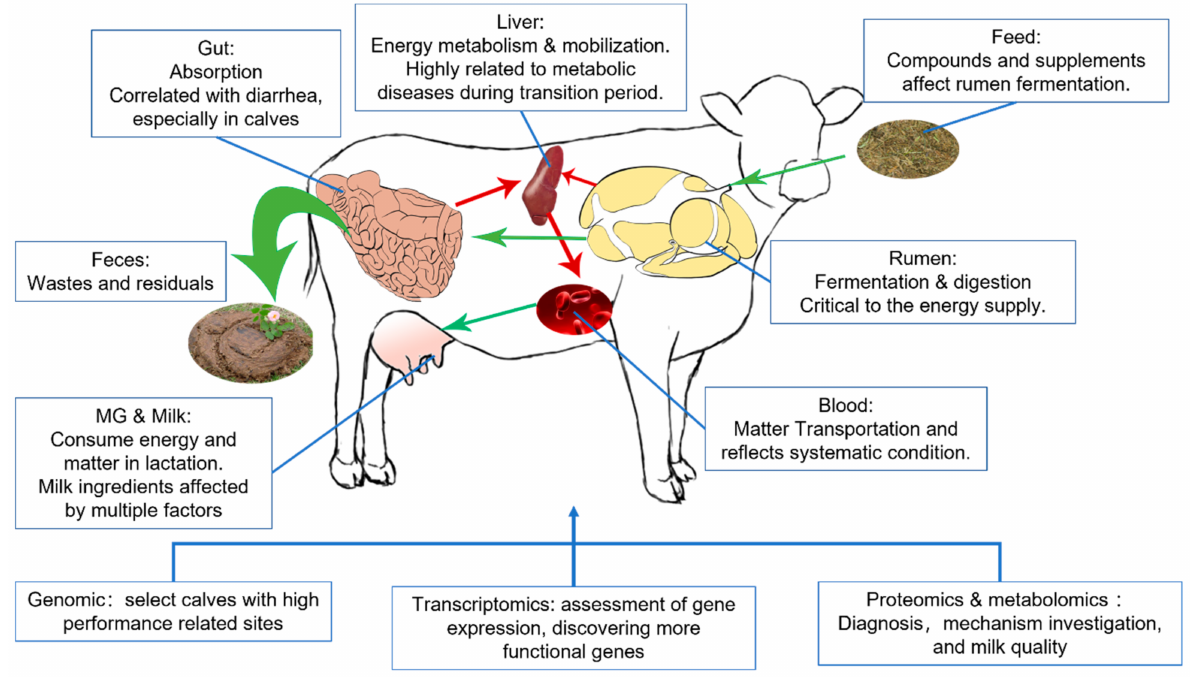
Figure 1. Organs mainly involved in the lactation physiology and utilities of omics. Green and red arrows stand for the nutrition transport and energy supply